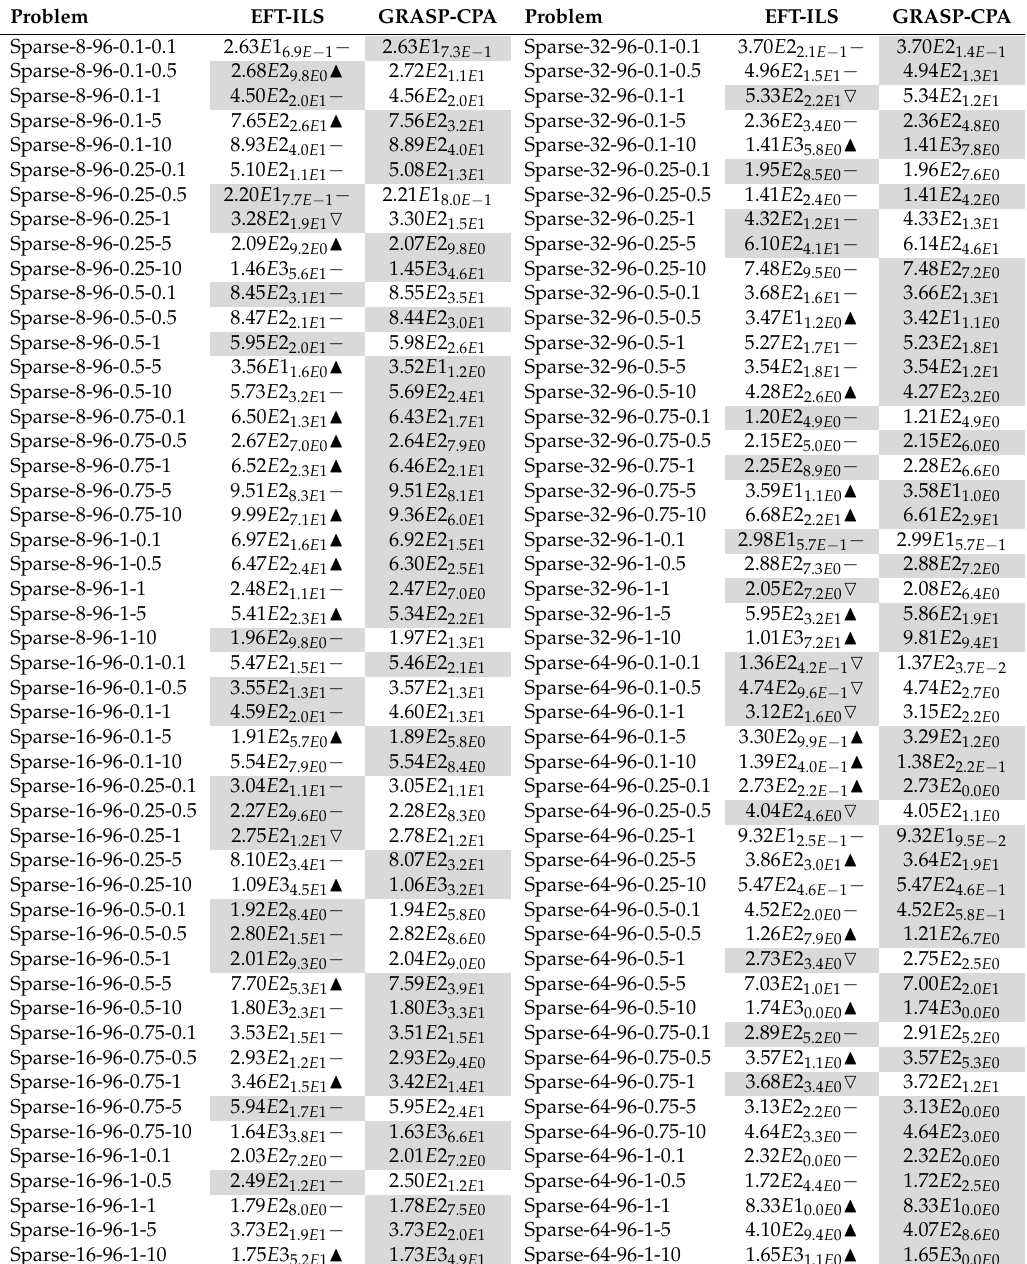
Table 7. Sparse instances median and IQR of EFT-ILS and GRASP-CPA over 100 independent runs. Light gray emphasizes the best results. Problem